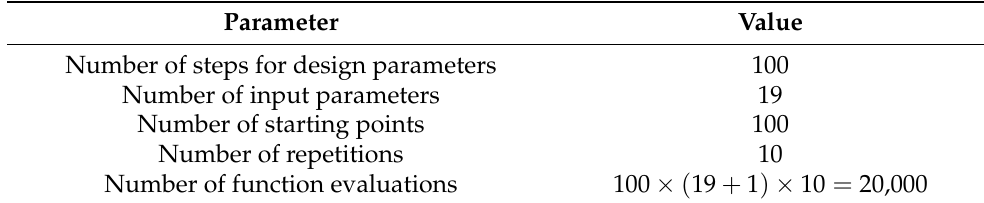
Table A3. SA settings and computational